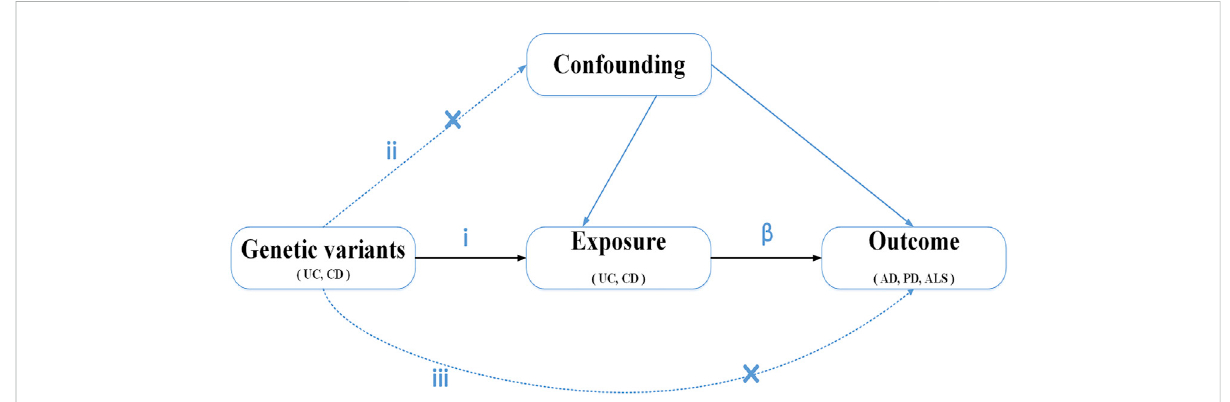
FIGURE 1 Diagram of Mendelian randomization study design:i) The genetic variants selected as instrumental variables (IVs) should beassociated with the exposure ( P < 5E-8). ii) genetic variants are not related to other confounder factors. iii) genetic variants would have an effect on the outcomes (ND) only via exposure (UC and CD), not via any alternative pathways. β , causal